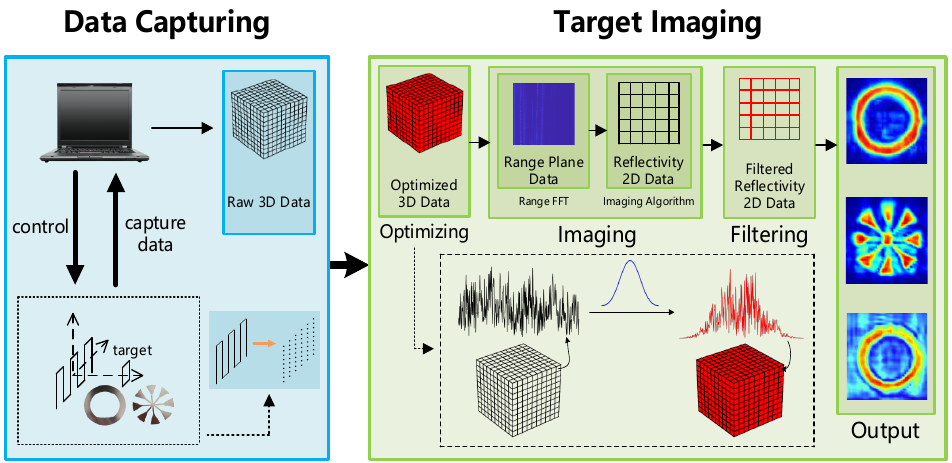
Figure 1. Processing Flow (The left side is data capturing, realized by SAR; the right side is target imaging, which contains three steps of optimizing, imaging, and